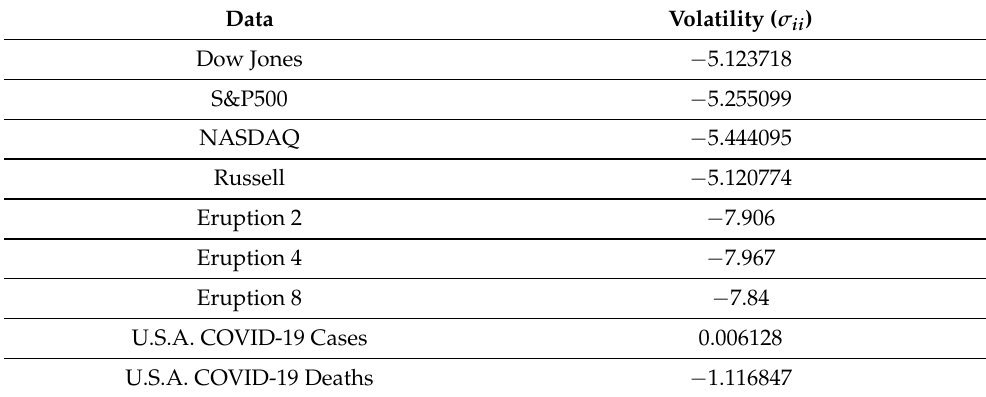
Table 5. lVolatility Values Estimated Using R stochvol package.